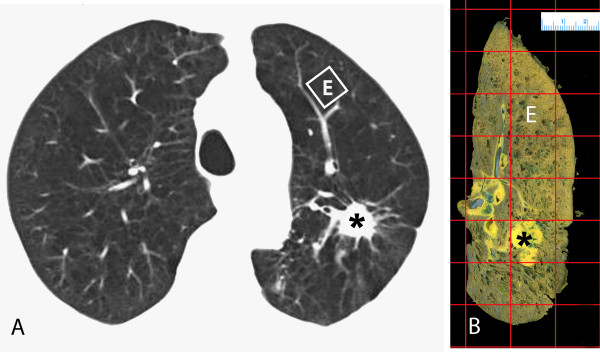
Matching CT Images and Lung Specimens. A CT image of a representative subject is shown in Figure 1A and the corresponding slice of the resected specimen is shown in Figure 1B. For reference and orientation, the tumor is marked by a star (*). A grid is superimposed over the fixed lung slice (Figure 1B) and a 2 × 2 cm square section (square E) is randomly selected for histological processing and measurement of surface area per unit lung volume (SA/V). The corresponding region (square E) on CT is then identified (Figure 1A); the CT median lung density and the CT cluster analysis value D are obtained in the region of interest using the computer program (EmphylxJ). The size of the square E on CT has been corrected for lung inflation to match the size of the histological specimen.